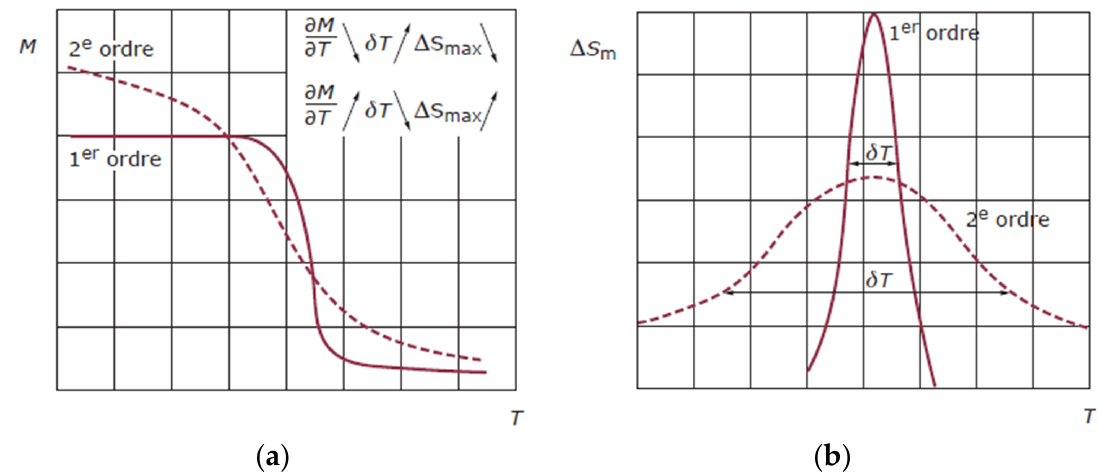
Figure 2. Comparison between first and second order magnetic phase transition for: ( a ) the thermal variation of the magnetization and ( b ) the maximum entropy variation [4].